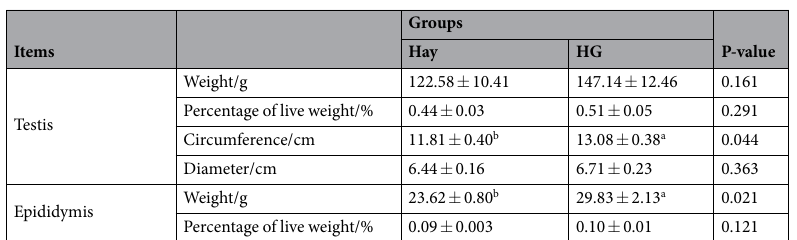
Table 2. Testicle indices of hay and HG groups. a,b,c Different letters denote statistically significant differences within each index ( p < 0.05).